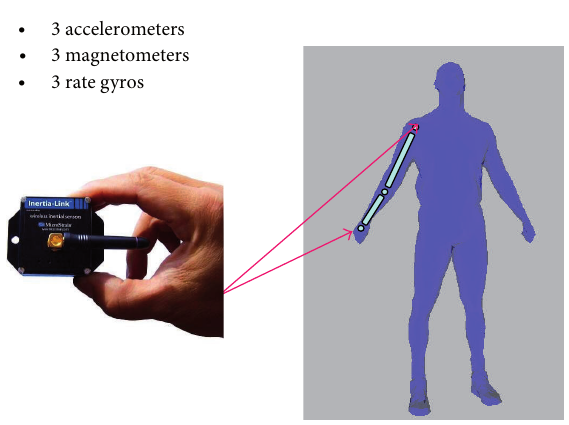
Figure 3: Position of the attitude